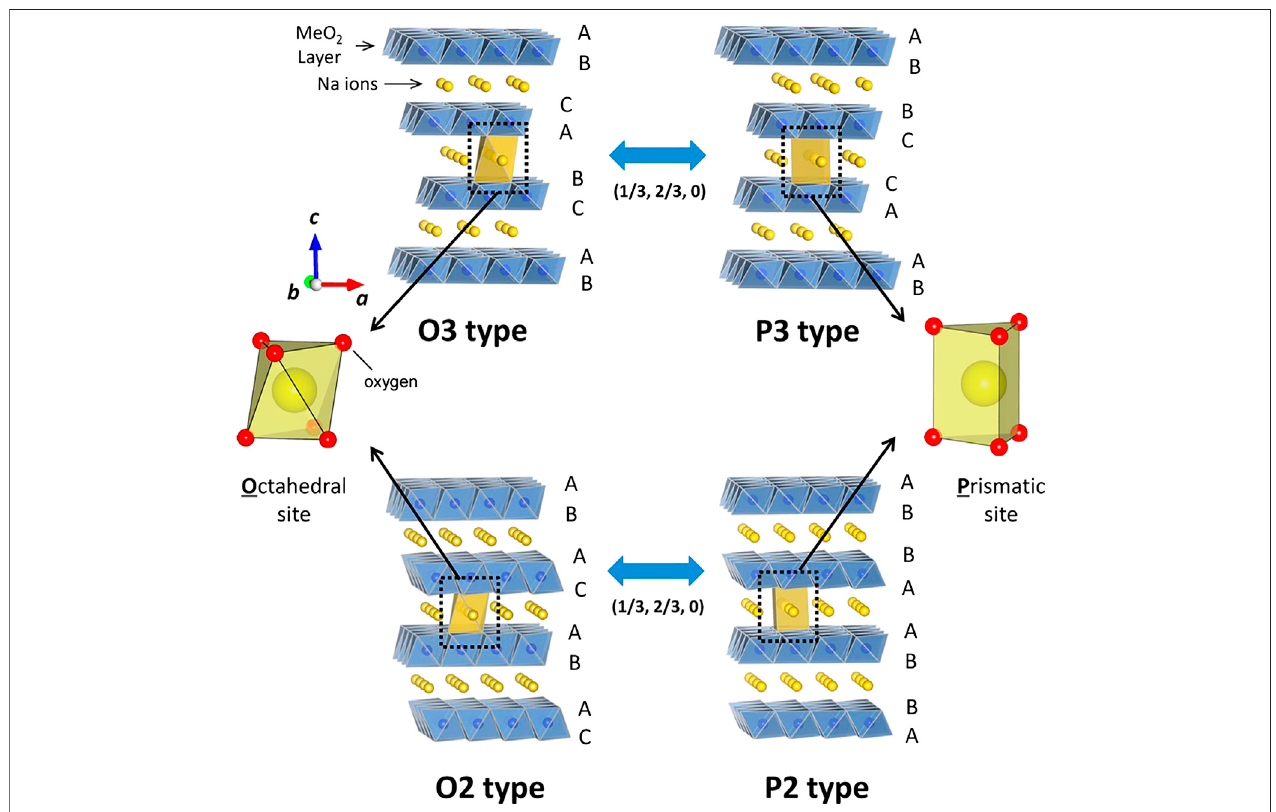
FIGURE 1 | Classi fi cation of Na − Me − O layered materials with sheets of edge-sharing MeO6 octahedra and phase transition processes induced by sodium extraction. Reprinted with permission from [ref. Yabuuchi et al. (2014)]. Copyright (2014) American Chemical Society.